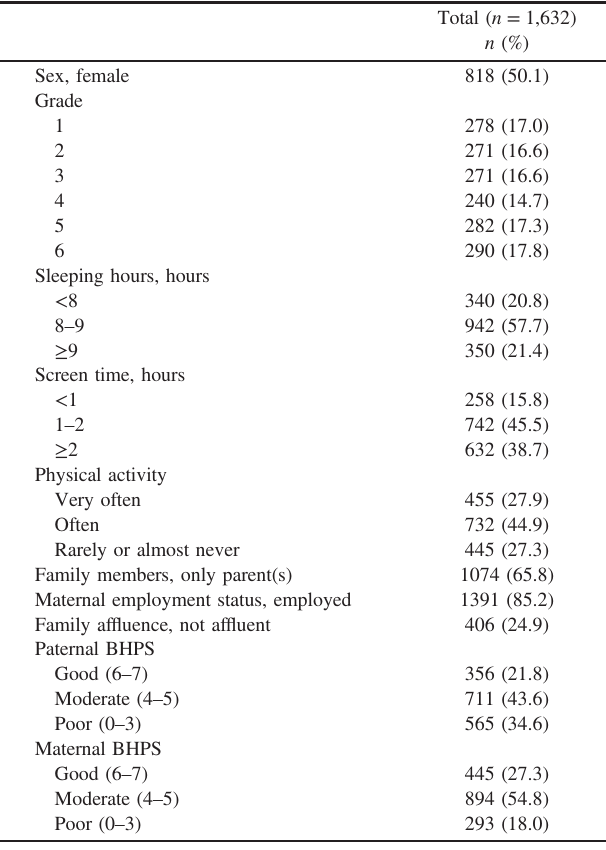
Table 1. Characteristics of the participants